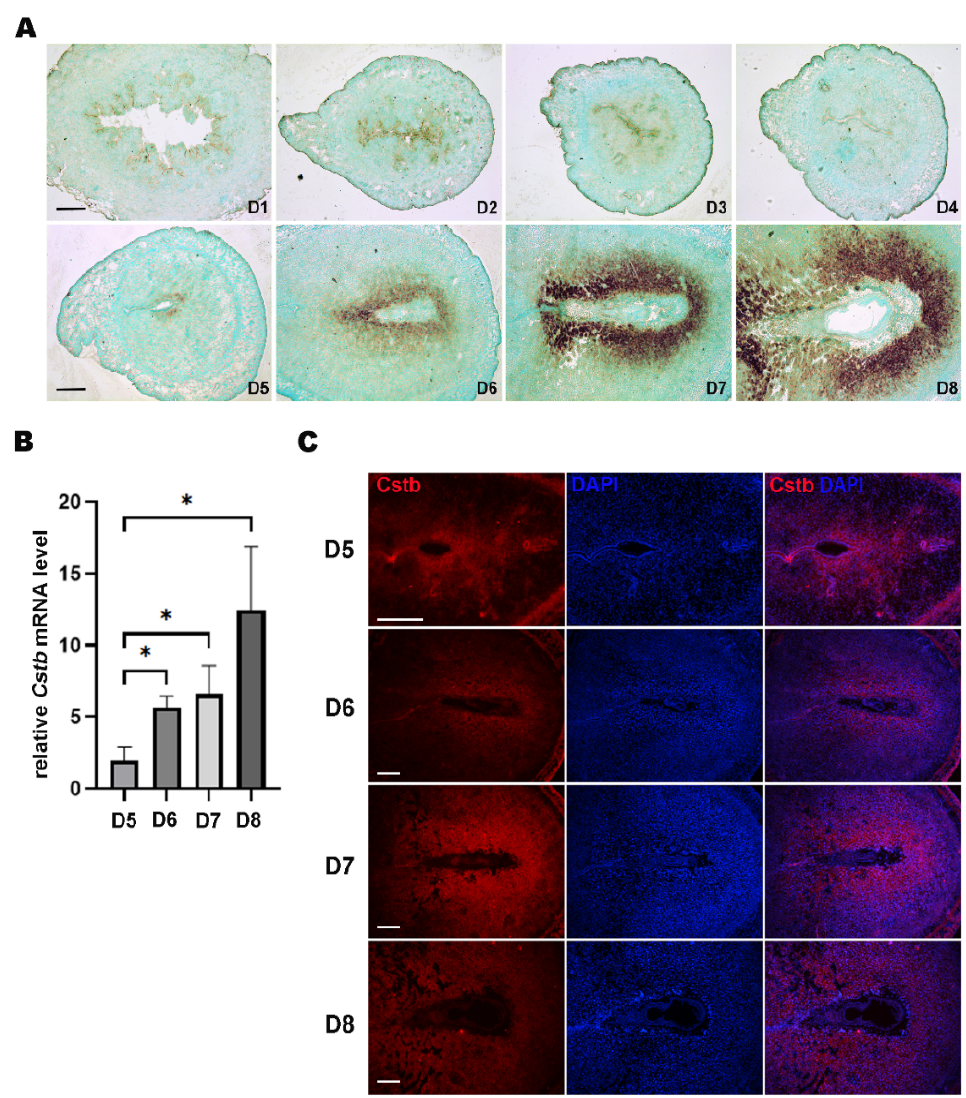
Figure 1. Expression of Cstb in the mice uteri during early pregnancy. ( A ) In situ hybridization showing the expression of Cstb in mice uteri from days 1 to 8 of pregnancy. Bar = 300 µ m. ( B ) RT- qPCR of Cstb mRNA level in the mice uteri from days 5 to 8 of pregnancy. ( C ) Immunofluorescence of Cstb protein from days 5 to 8. The sections were stained with Cstb antibody (red), and the nuclei were counterstained using DAPI (blue). Bar = 300 µ m. * p < 0.05.